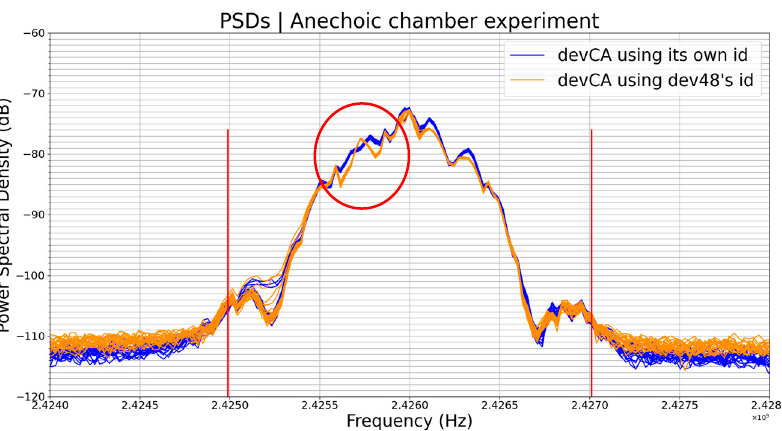
Figure 8. PSDs of the same BLE device but measured with two different identifiers. Table 5. Results of the comparison of the average PSDs of the same device transmitting two different identifiers.